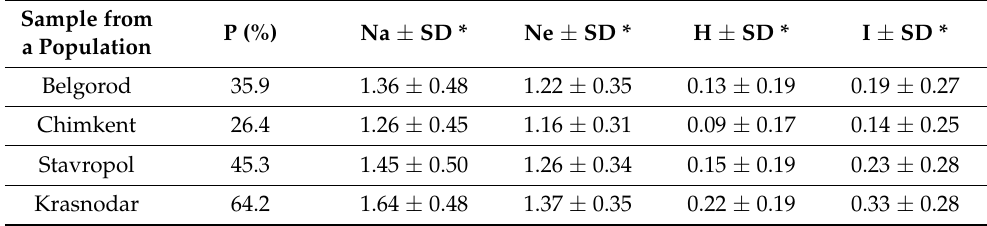
Table 3. DNA polymorphism and genetic diversity of H. hebetor populations.